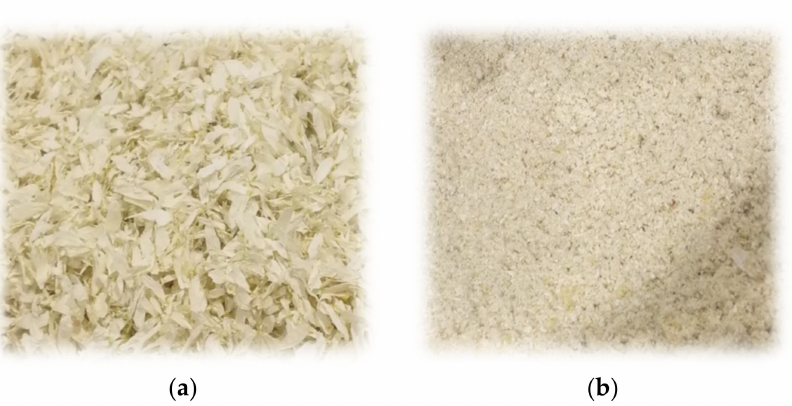
Figure 8. Matricaria recutita white ray florets before ( a ) and after ( b ) milling used for supercritical fluid extraction.